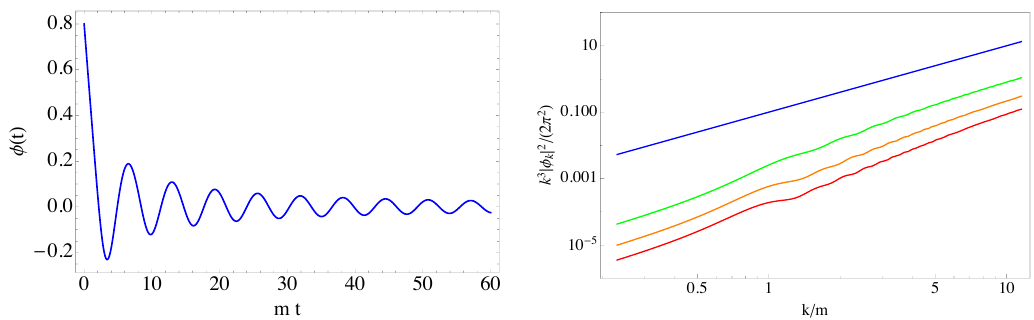
Figure 23 . Numerical results from Fibre in(cid:13)ation. Left : homogeneous (cid:12)eld evolution as a function of m t . Right: spectrum of the perturbations (cid:14)(cid:30) k at di(cid:11)erent moments in time: the initial spec- trum (blue), after the (cid:12)rst oscillation of (cid:30) (green), after four oscillations (orange), and after eight oscillations